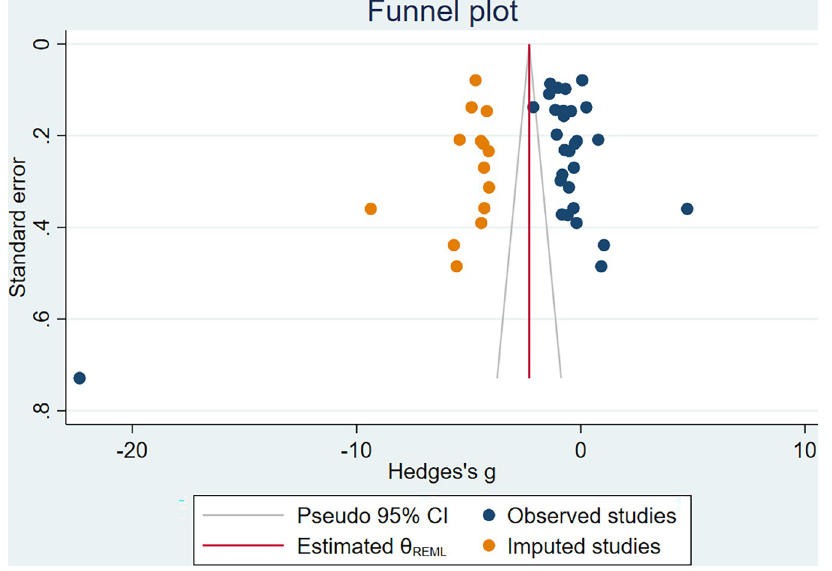
Fig 18. Trim and Fill funnel plot for the meta-analysis of BDNF levels in patients with DM.